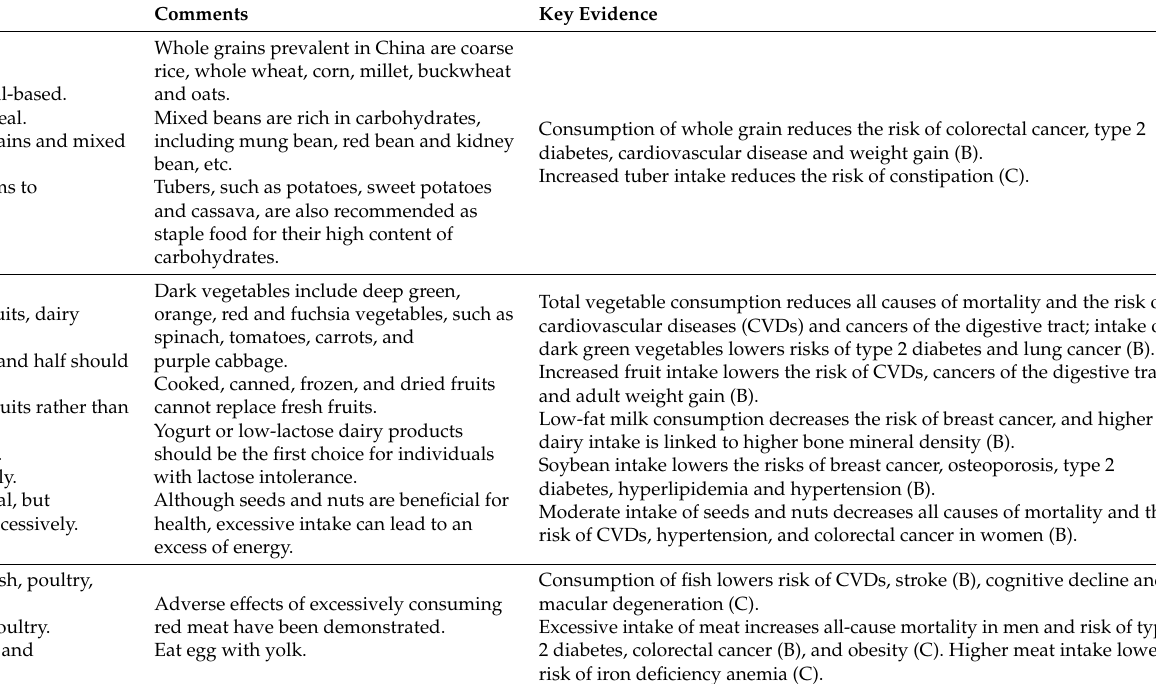
Table 1. Components and weighting of Chinese Healthy Eating Index (CHEI) mapped to the key recommendations of the Dietary Guidelines for Chinese-2016 (DGC-2016). Grades of the evidence (ranked as A, B and C) were based on the Food and Health Evidence Based Review [25].